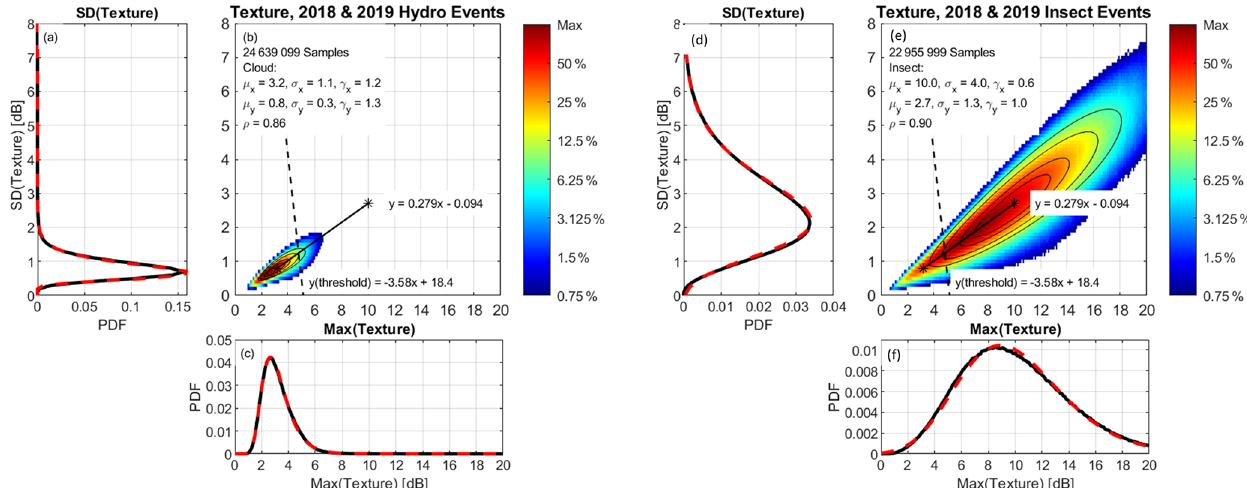
Figure A2. Observed spectral region texture distributions using the manual classified (a–c) hydrometeor scattering observations and (d– f) insect scattering observations. The 1D and 2D distribution formats are similar to Fig. 7. The colors in (b) and (e) represent observed distributions normalized to the pixel with the most observations. The contours are the 90%, 75%, 63%, and 50% occurrences of a fitted 2D generalized Gaussian function. The mean, standard deviation, and skewness parameters are listed in (b) for the hydrometeor scattering distribution and in (e) for the insect scattering distribution. The solid line and equation represent a line between the hydrometeor and insect scattering distribution centers with the asterisks placed at the distribution mean values. The dashed line is the orthogonal threshold line that is the intersection of the hydrometeor and insect true positive rates (TPRs). The solid and dashed lines are orthogonal but appear non-orthogonal in the panels because of axis scaling.